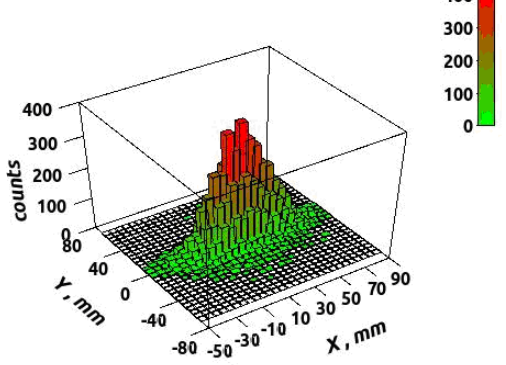
Fig. 8. The neutron two-dimension spatial distribution with the energy above 0.55 eV and the maximum energy 7 MeV .